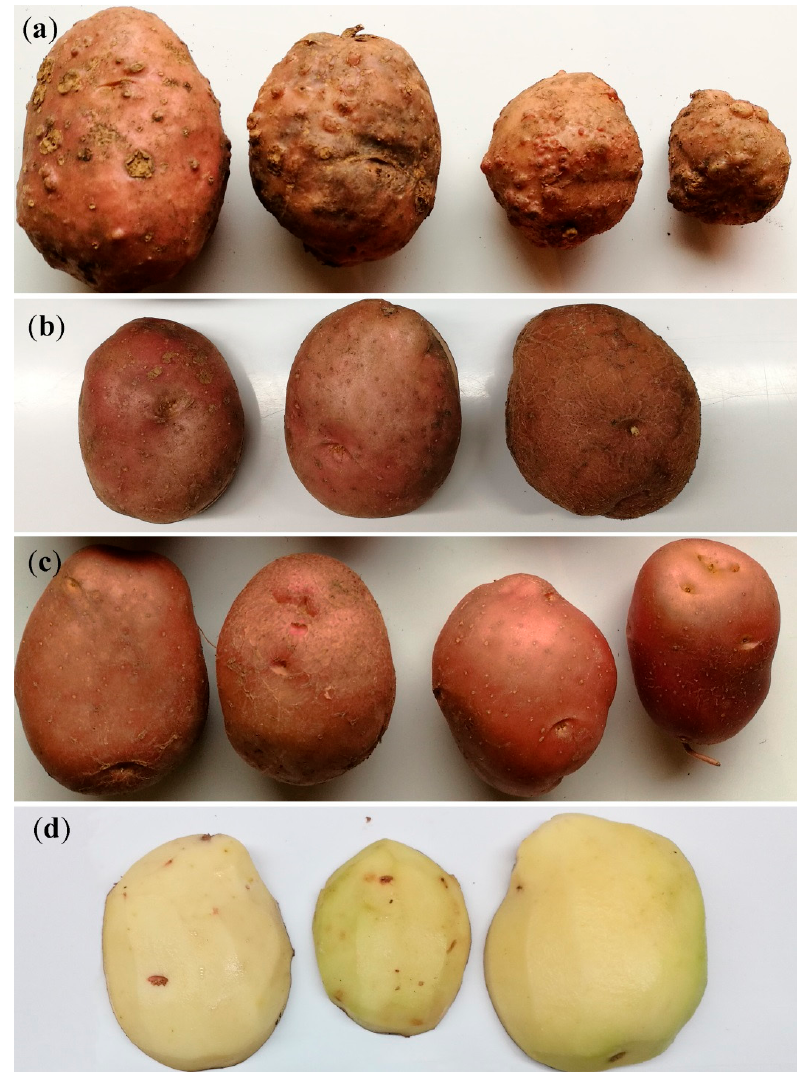
Figure 1. Cv. Desiree potato tubers after harvesting: ( a ) potato tubers from the RKN treatment with visible infestation symptoms—surface galls on potato tubers; ( b ) potato tubers from the RKN treatment without visual symptoms (i.e., latent infestation); ( c ) healthy, uninfested potato tubers from the control treatment; ( d ) peeled potato tubers from the RKN treatment without visual symptoms when unpeeled, with few visible necrotic spots below the potato tuber skin when peeled. For molecular detection, potato tubers infested with M. luci , i.e., from the RKN treatment, were divided into two groups: (1) tubers with visible symptoms; (2) tubers with no visible symptoms on the unpeeled tuber, i.e., latent infestation (Figure 1). Healthy, i.e., uninfested, tubers were used as control group. Individual females with egg mass attached were dissected from potato tuber tissue using a scalpel and nematological needle. Potato tubers were sampled 48 days after harvest for DNA isolation and stored in a refrigerator at 6 ± 2°C until further sampling 81 days after harvesting.